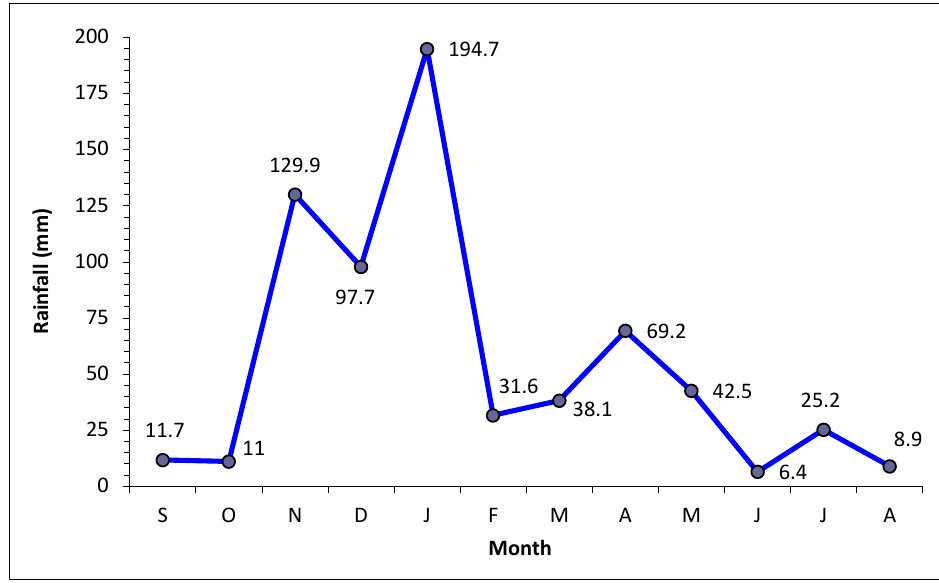
Figure 28. Monthly fluctuation of the rain at the rainfall station of Hammam-Grouz dam during the hydrological year (2002-2003) These rains, significant in this semi-arid area, quickly brought the water level in the dam, and for the first time since its impoundment, to a level higher than normal. What put all the elements of the dam (the dike, the banks, the bottom of the lake, the piezometers, the Tasso meters etc.) under the most important pressure today. This pressurization revealed water resurgences downstream of the dam and emerged the lower gallery. Indeed, because of the importance of the water losses recorded, the volume of water stored in the bowl underwent rapid lowering. This lowering is due to the maneuvers of the drain valves and the high leakage